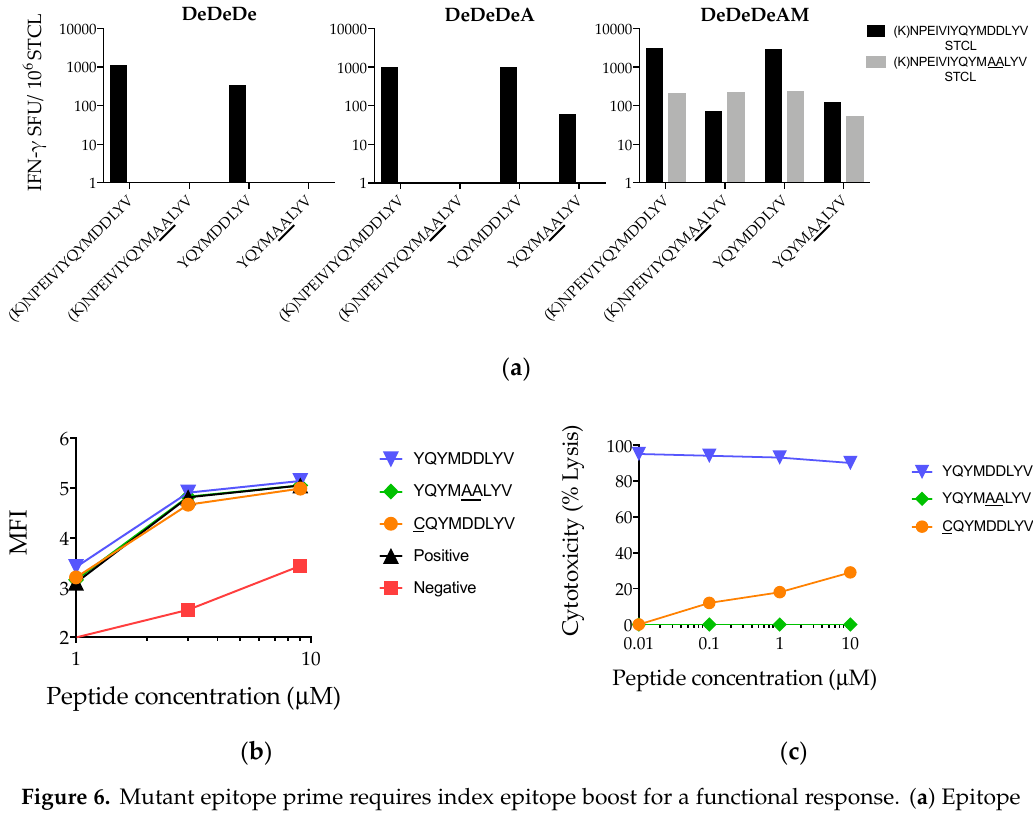
Figure 6. Mutant epitope prime requires index epitope boost for a functional response. ( a ) Epitope variants YQYMDDLYV and YQYMAALYV were delivered by the HIVconsv (De for electroporated DNA and M for MVA) and GRIN (Gag-RT-Integrase-Nef) (A for adenovirus) vaccines, respectively. PBMC from volunteer 884 drawn 2, 8, and 12 weeks after DeDeDe, DeDeDeA and DeDeDeAM, respectively, were expanded by either the HIVconsv (black) or GRIN (gray) 15-mer peptide variant and tested against both the parental 15-mer and 9-mer peptides in an ELISPOT assay. ( b ) Recombinant purified HLA-A*02:01 heavy chain and β 2 -microglobulin were used to test efficiency of refolding of HLA-peptide complexes in the presence of decreasing test peptide concentrations using a FACS bead assay. ( c ) Killing of peptide-pulsed HLA-A*02:01 target cells by a YQYMDDLYV-specific CD8 + T cell clone. CQYMDDLYV present in 1.32% of database sequences was used as a variant example of a strong binder with impaired T-cell stimulation.